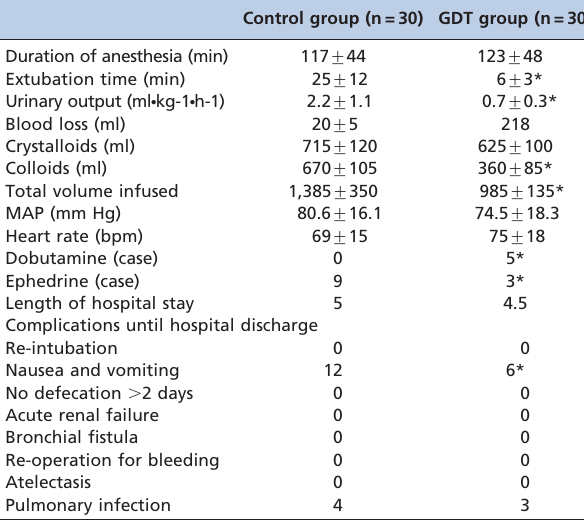
Table 3 - Perioperative period